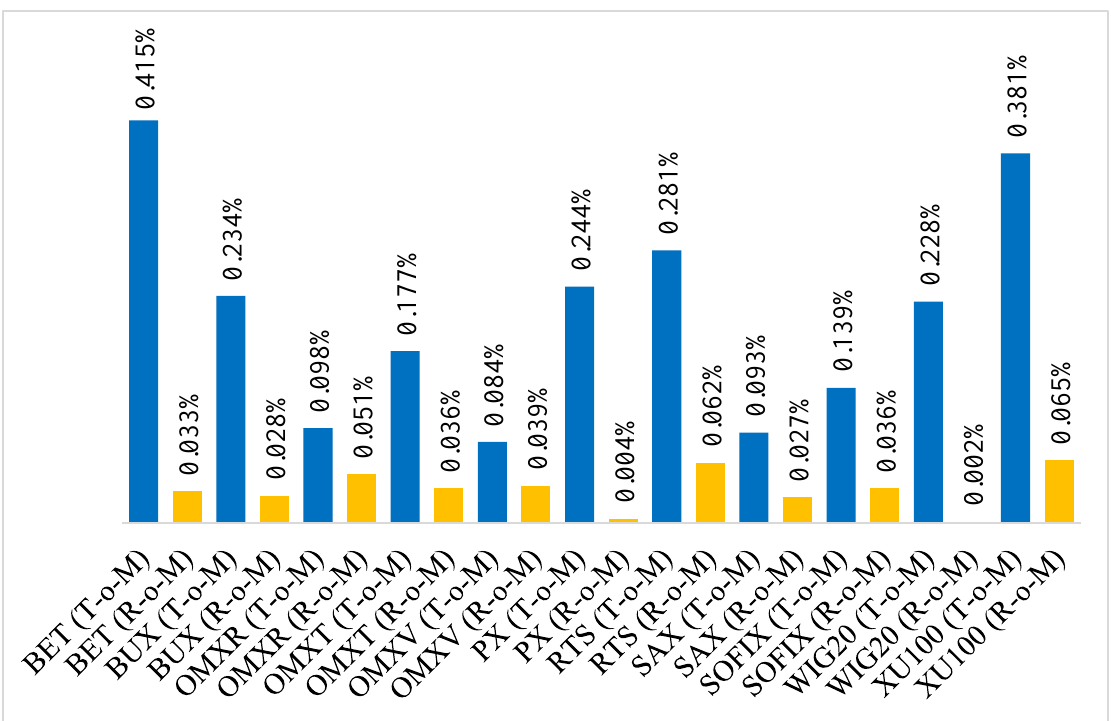
Figure 1. Comparison of average daily returns—Turn of the month window (1+1).